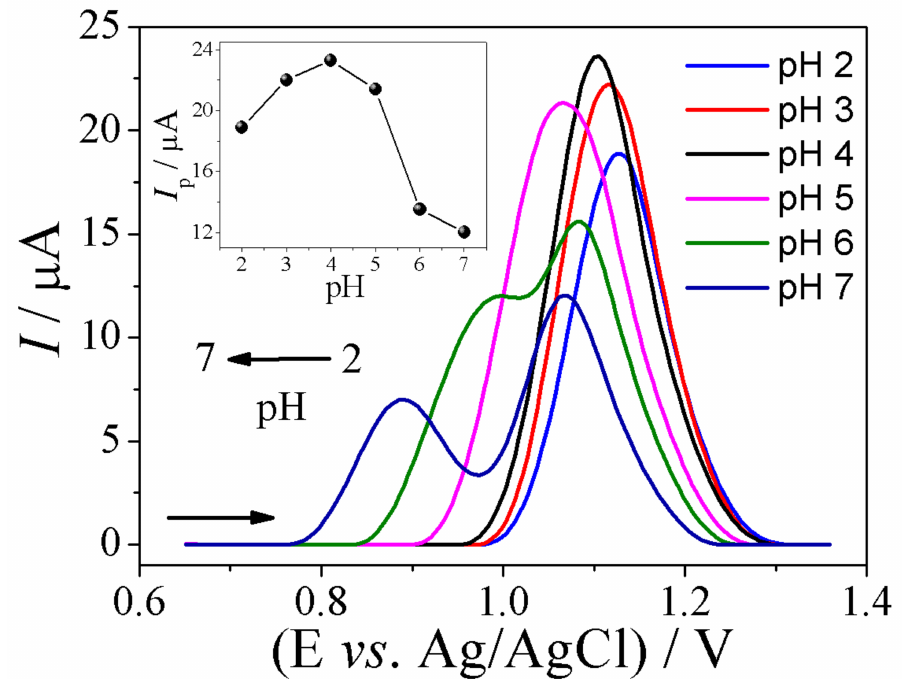
Figure 6. Results obtained from SWV analysis conducted based on the application of the Bi-rGO- CTS/GCE sensor in 0.04 mol L − 1 Britton–Robinson buffer solution containing 5.0 µ mol L − 1 of 3-methylmorphine at pH ranging from 2.0 to 7.0. Parameters: f = 15 Hz; a = 50 mV; ∆ E s = 5 mV. Inset: I p vs. pH